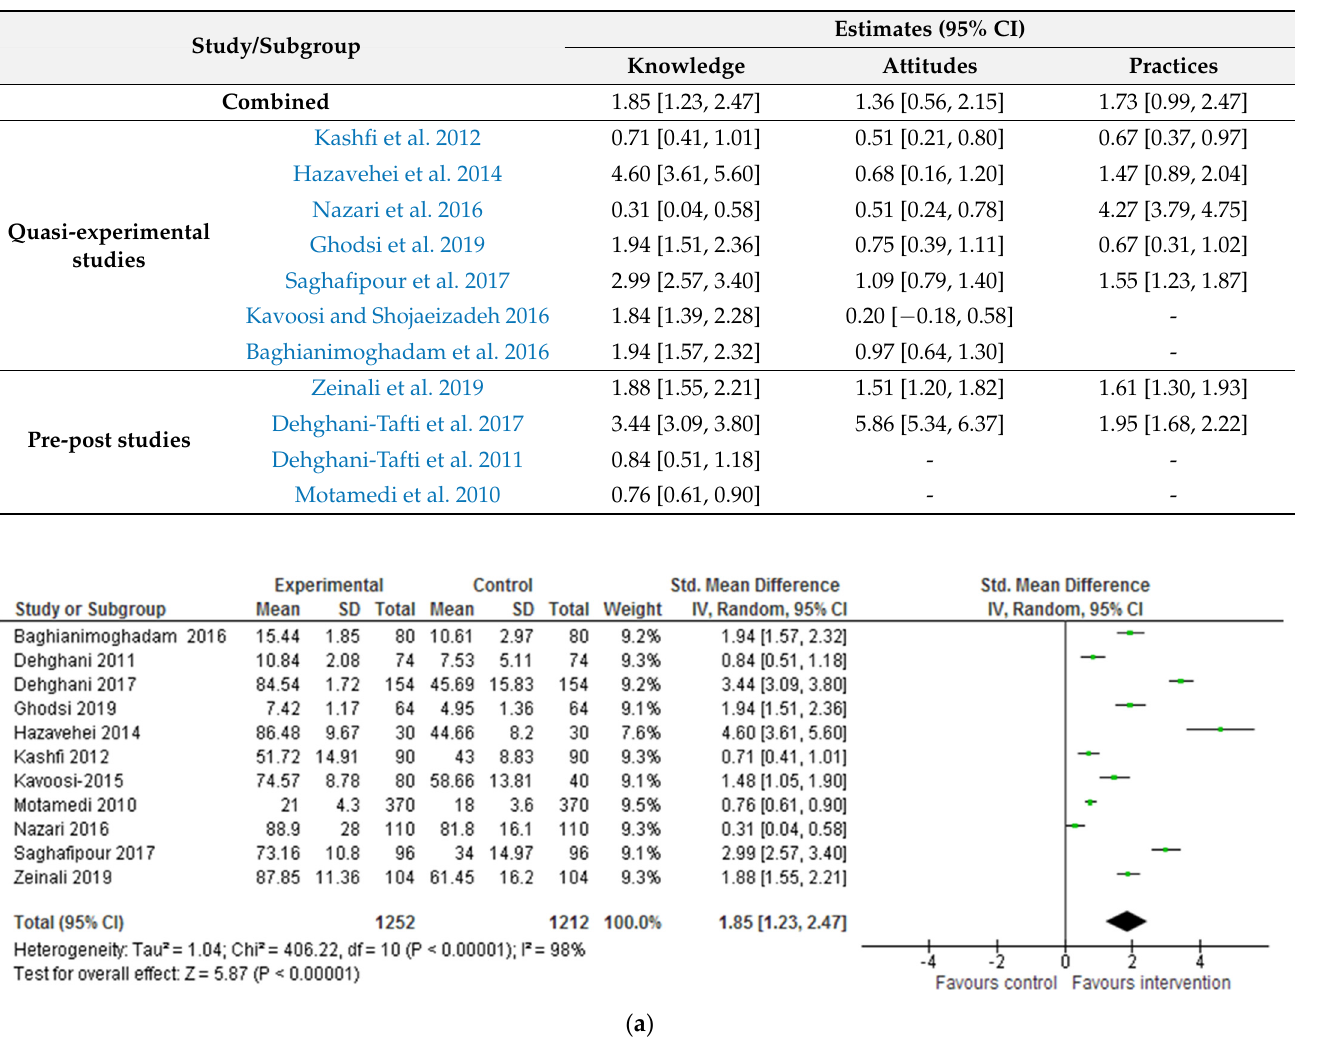
Table 4. Summary estimates of standardised mean difference (SMD) for the overall and subgroups studies.